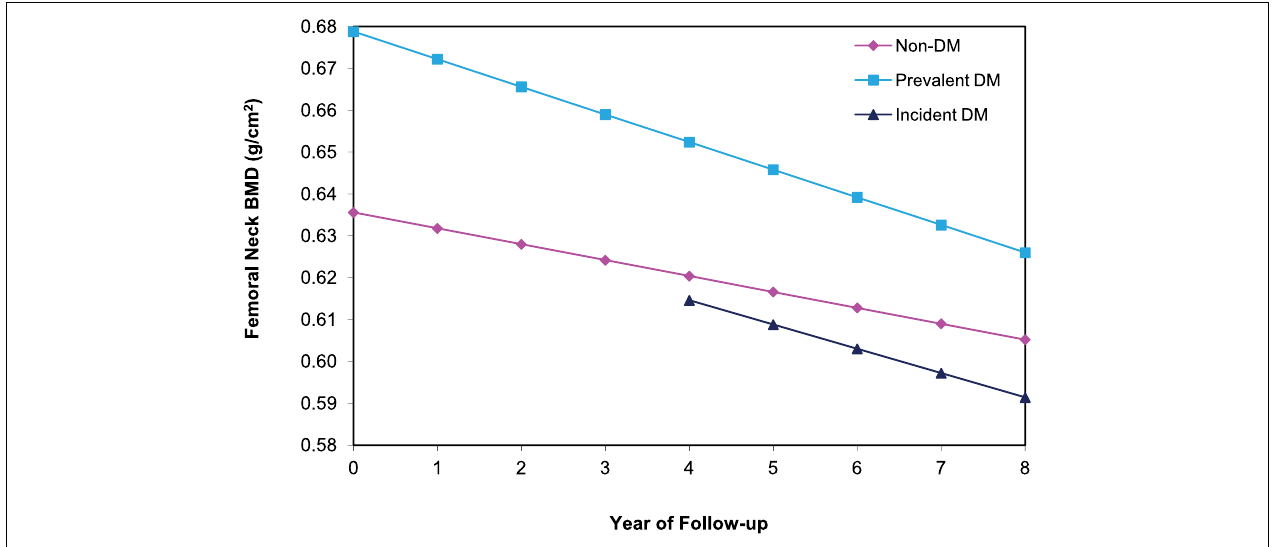
FIGURE 2 | BMD over time at the femoral neck among older women by diabetes status . Mixed model estimates, adjusted for age and clinic site, were used to estimate BMD at each year of